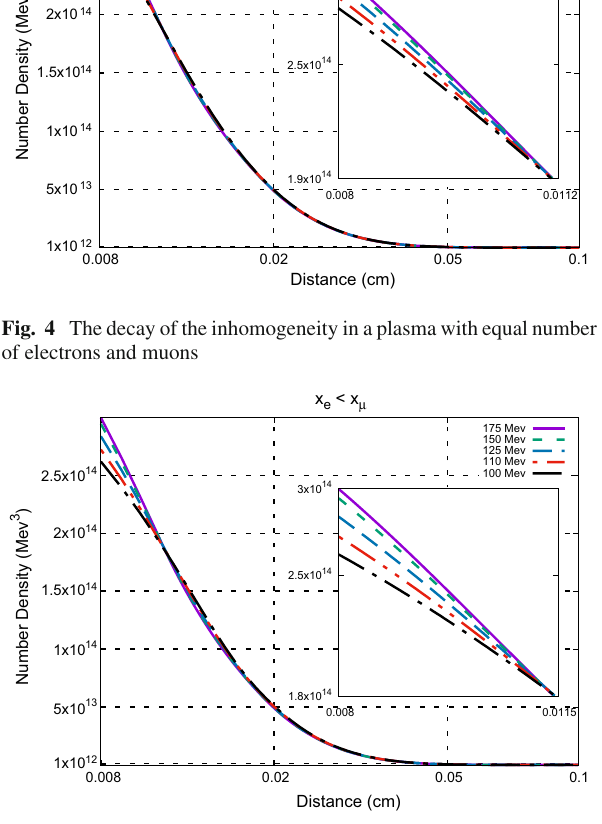
Fig. 5 The decay of the baryon inhomogeneity in a muon rich plasma